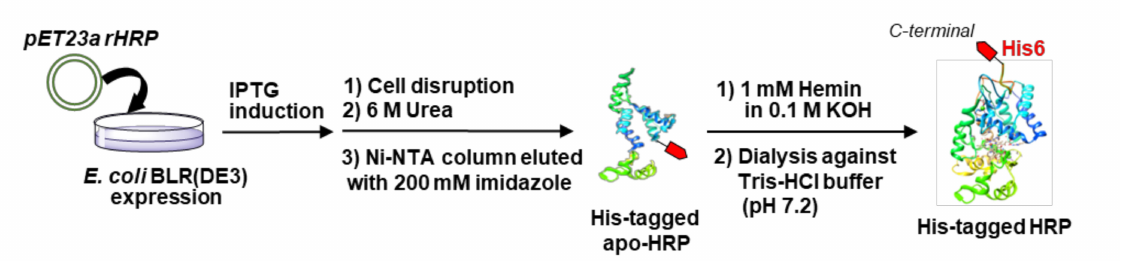
Figure 5. Schematic illustration of the preparation of His-tagged